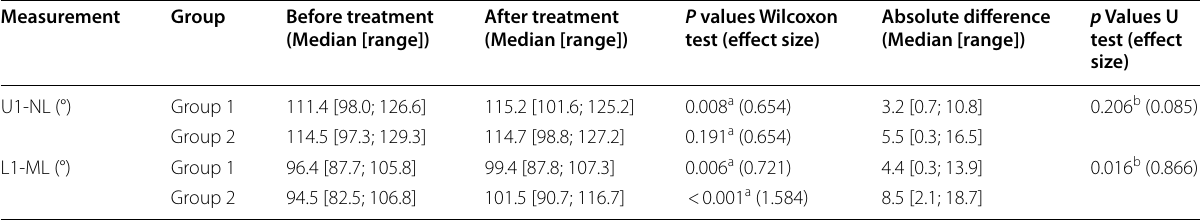
Matched pairs (before vs. after treatment, B-A) were compared with the Wilcoxon signed-rank test, and pairwise comparisons of the measurements between group 1 and group 2 were analysed using Mann–Whitney U test, and p values and effect sizes (Cohen’s d )